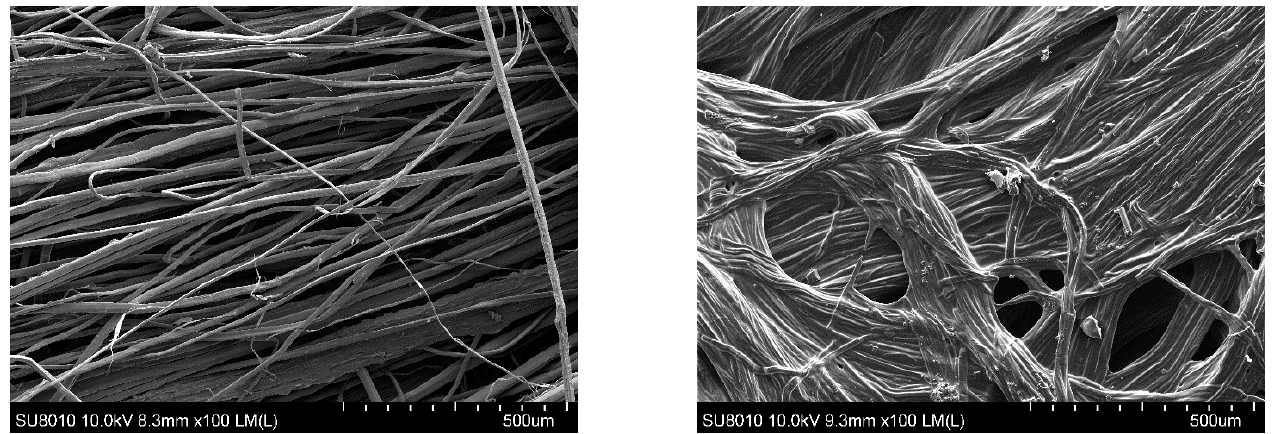
Figure 9. SEM images of G ( a ), A ( b ), C ( c ), B ( d ), and F ( e ) fabrics before CC tests (left column) and VGACBF composites after CC tests (right column).